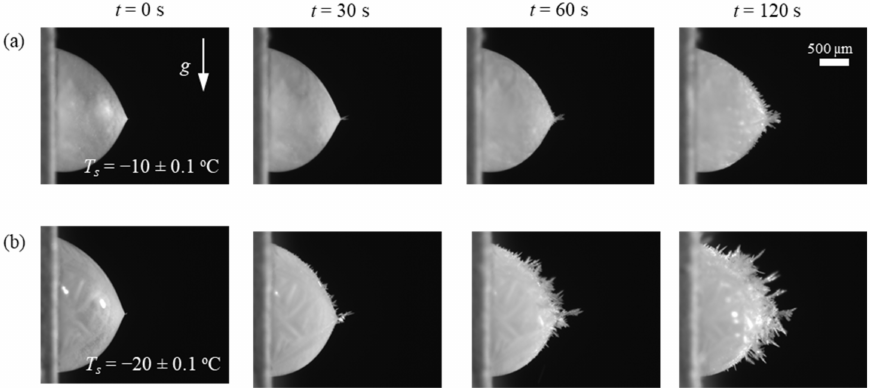
Figure 7. Growth dynamics of ice dendrites atop a frozen water drop placed on a vertically orientated substrate at ( a ) T s = − 10 ± 0.1 ◦ C, and ( b ) T s = − 20 ± 0.1 ◦